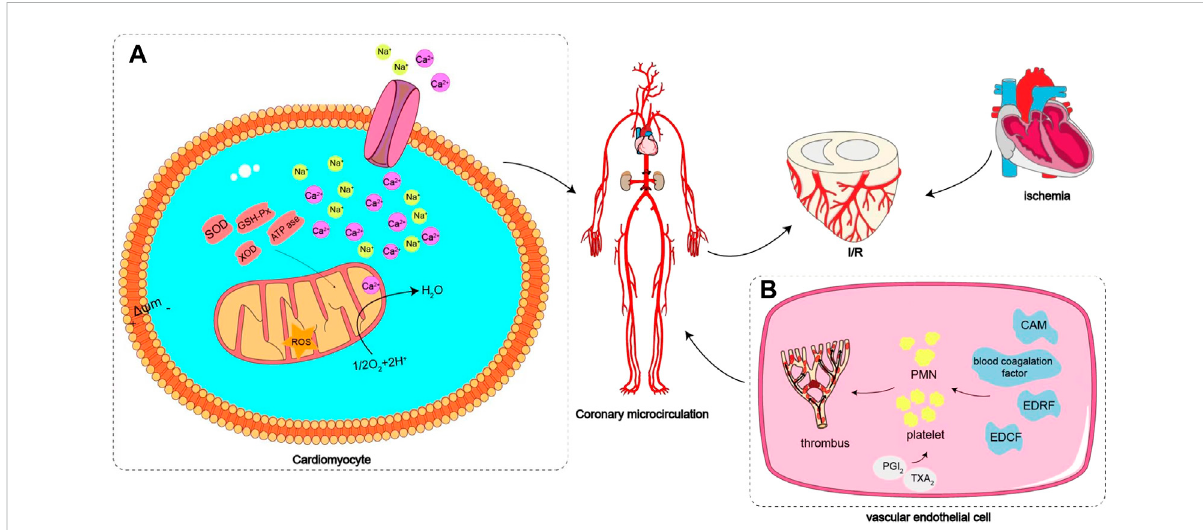
FIGURE 3 Protective effect of Valeriana on myocardial ischemia – reperfusion injury: (A) SOD, GSHPx, and ATPase activities were increased in cardiomyocytes, and Ca 2+ levels in cardiomyocytes were remarkably reduced. (B) Inhibiting a variety of CAMs, blood coagulation factor and EDRF, increasing EDCF and the value of PGI2/TXA2 and inhibiting platelet aggregation to improve coronary